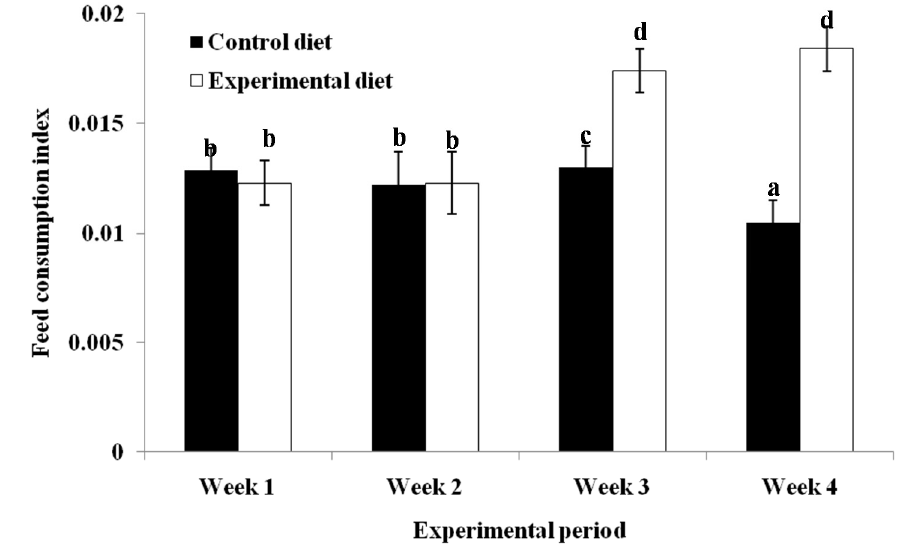
Figure 3. Feed Consumption index during the experiment. All data are the mean ± SD of three replicates. Mean followed by different letters in the same column differ significantly ( p < 0.05) between the control and experimental